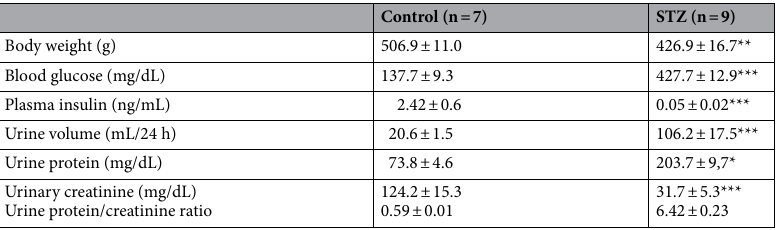
Table 1. Physiological parameters of STZ rats on Day 7, body weight, blood glucose, plasma insulin, urine volume, urine protein concentration, urinary creatinine, urine protein/creatinine ratio. Mean ± SEM, * P < 0.05, ** P < 0.01, *** P <